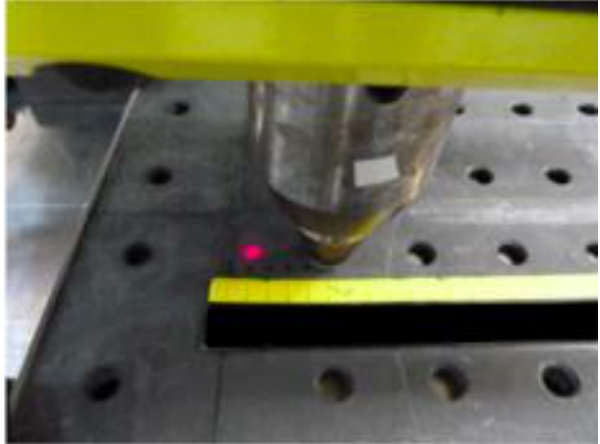
Figure 2. Distance between the laser spot and the pin